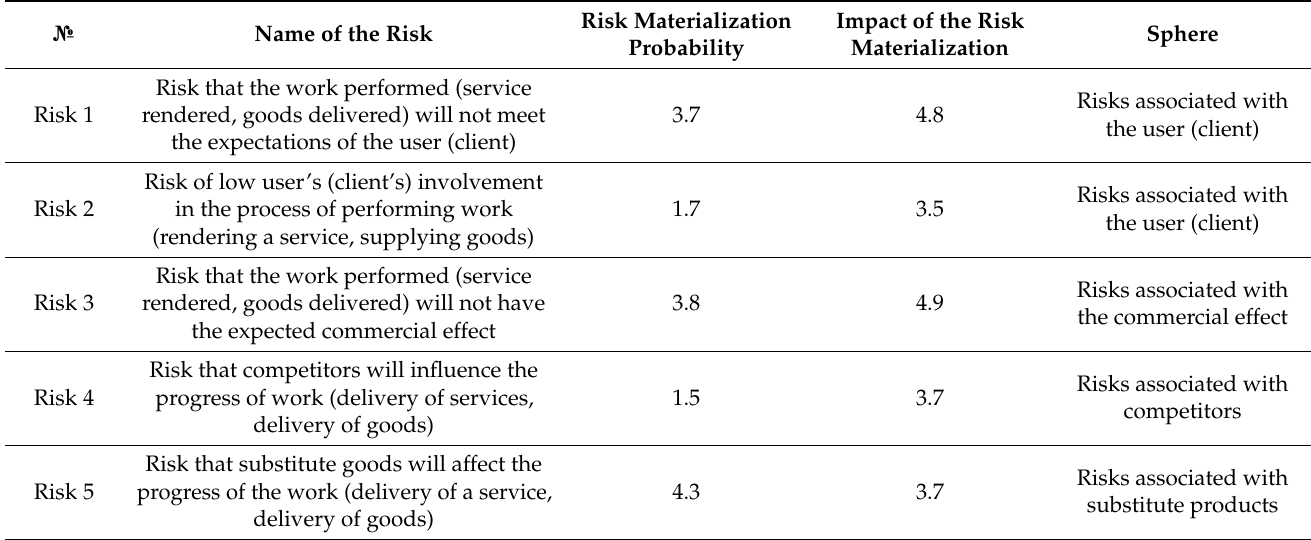
Table 5. Commercial risks of IT